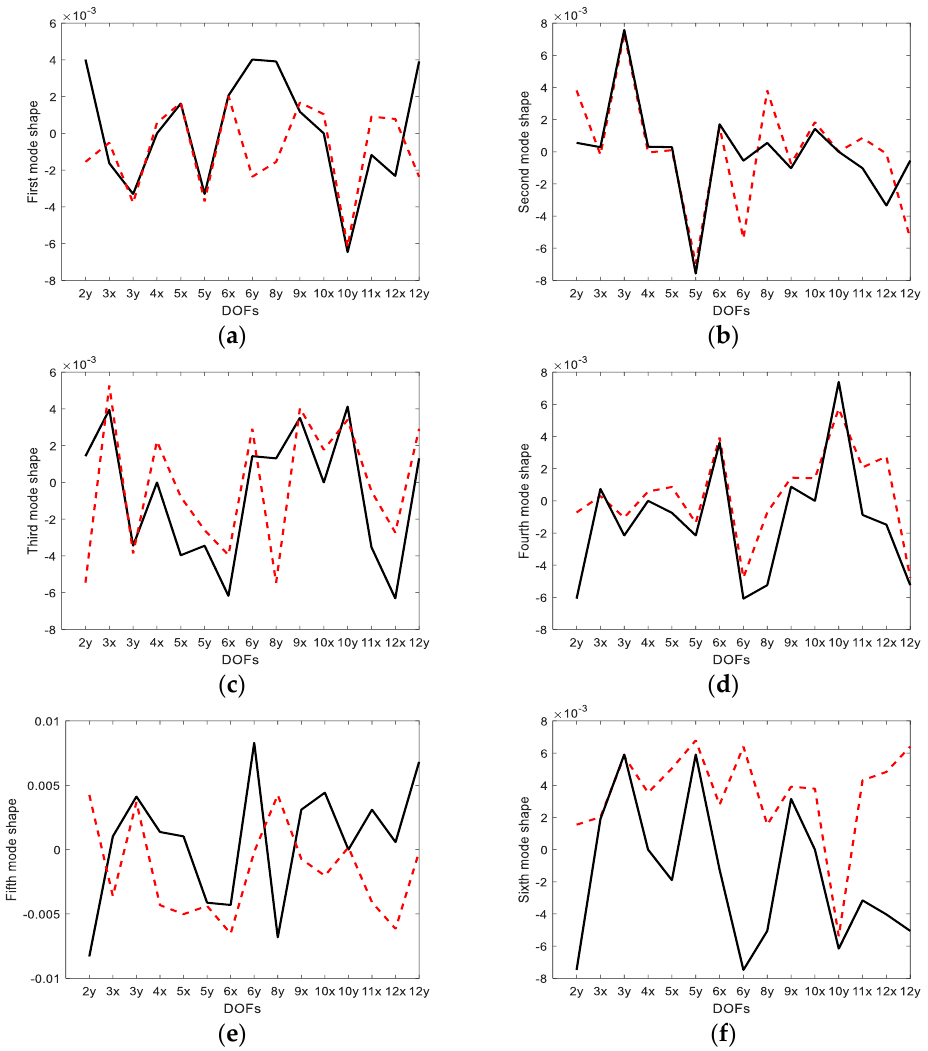
Figure 5. Comparison of estimated and actual mode shapes (EI approach) at slave DOFs: ( a ) first mode; ( b ) second mode; ( c ) third mode; ( d ) fourth mode; ( e ) fifth mode; ( f ) sixth mode. The solid line indicates the actual mode shape and the dotted line is the estimated mode shape.